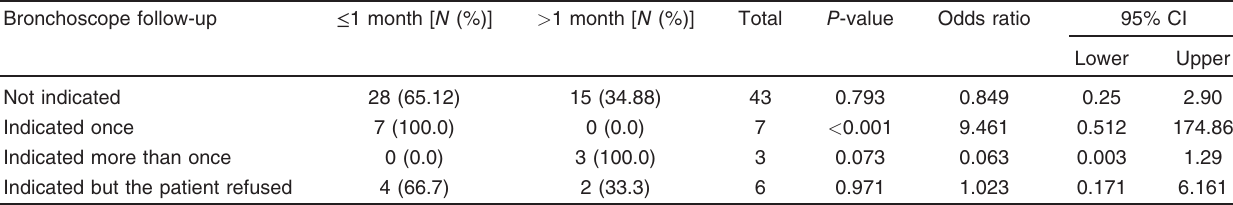
Table 3 Comparison between the need for rebronchoscopy and the duration of follow-up Bronchoscope follow-up